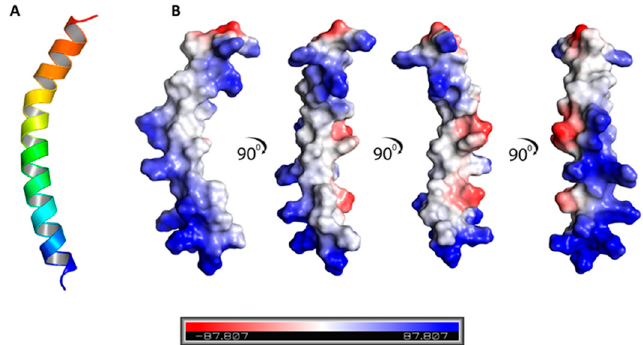
Figure 1. ( A ) Predicted 3D structure of the cecropin A peptide using AlphaFold-2. The predicted structure adopted an α -helix configuration. ( B ) Surface analysis of the predicted structure revealed alternate distribution of the charged amino acids (positively charged amino acids, blue, and negatively charged amino acids, red) and hydrophobic amino acids creating an amphipathic feature.